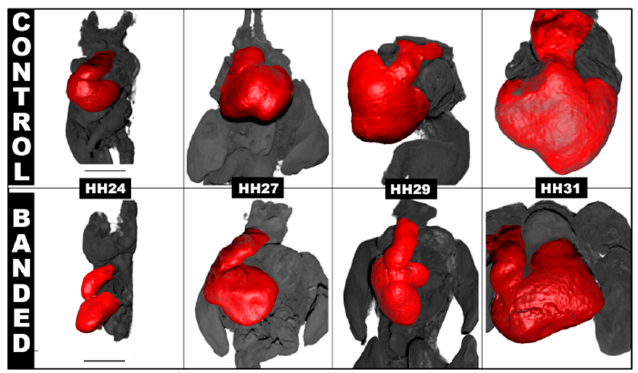
Figure 8. Reconstructed anatomies of chicken embryo hearts at different developmental stages from 3D microCT scans. The figure compares normal heart development (control) with abnormal cardiac development due to OTB (banding intervention). Morphologically, the banded hearts tend to have a bean-like shape form when compared to the control hearts. This is perhaps more visible in the HH24 and HH29 images here, in which the control hearts are approximately 1.5-fold wider than banded hearts with surface features that portray the ongoing septation of the primitive ventricle. Scale bar is 1 mm, and all images are the same scale. Atrial ligation (AL) generates an imbalance of flow between the right and left sides of the heart, early during development that alters ventricular proportions. In LAL per- formed at HH21, a redistribution of flow to the right side of the heart leads to underde- velopment of the left side (hypoplasia of the left ventricle) with compensatory overdevel- opment of the right side as soon as HH29. Left ventricle myocardial volume decreases while left side trabecular compaction accelerates. The right ventricle shows chamber dila- tion with altered trabecular pattern and proliferation [71]. In contrast, in RAL, the flow imbalance leads to overdevelopment of the left heart and underdevelopment of the right heart. Hemodynamic load also affects trabecular architecture. In OTB, elevated hemody- namic load results in an acceleration in trabecular compaction when compared to control embryos at the same stage. The increased myocardial proliferation and trabecular com- paction leads to a thicker ventricular wall, together with a denser and more spiraled tra- becular pattern [71,88]. Varying band tightness, which leads to varying levels of hemody- namic load, contributes to a spectrum of changes observed after OTB both in shape and trabecular architecture (e.g., Figure 9). Figure 9. Histological images of the developing ventricles at HH29 demonstrate different ventricu- lar morphology following OTB. Sectioned chicken embryonic hearts at HH29 were stained with Hematoxylin (nuclear marker) and Eosin (cytoplasmic maker) and imaged at 20× magnification. The figure compares the ventricles of ( A ) a control heart, ( B ) an OTB heart with a band tightness of 42%,